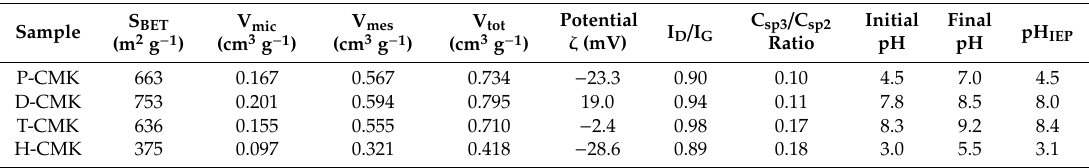
Table 1. Results derived from the nitrogen sorption, ζ potential, Raman, XPS measurements, and pH